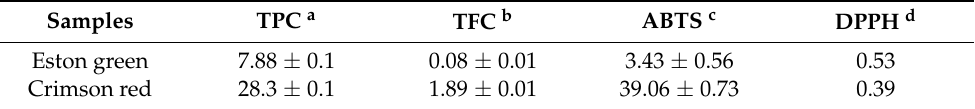
Table 2. Total phenolic, flavonoid contents, and antioxidant activity of lentil hull aqueous extracts of Eston green and Crimson red varieties that were obtained under microwave irradiation. Samples TPC a TFC b ABTS c DPPH d Eston